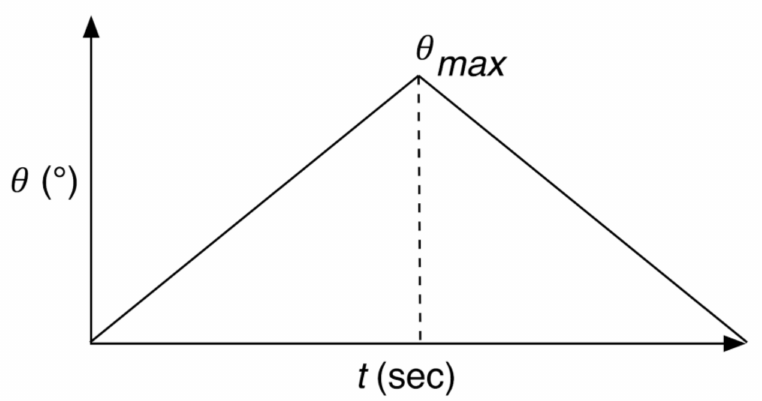
Figure 1. Graphical representation of the angle ( θ ) as a function of time in seconds, as it is recorded in the data logs.